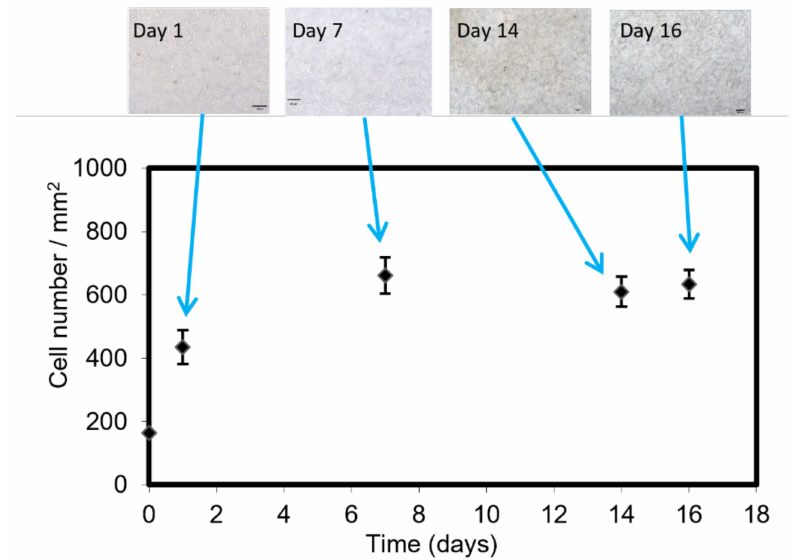
Figure 4. Cell density in large-area microfluidic bioreactor. On day 7, the growth culture medium was changed to the production medium. Image magnification: 20 × , Bar: 100 µ m. Error bars indicate standard error of the mean determinations.